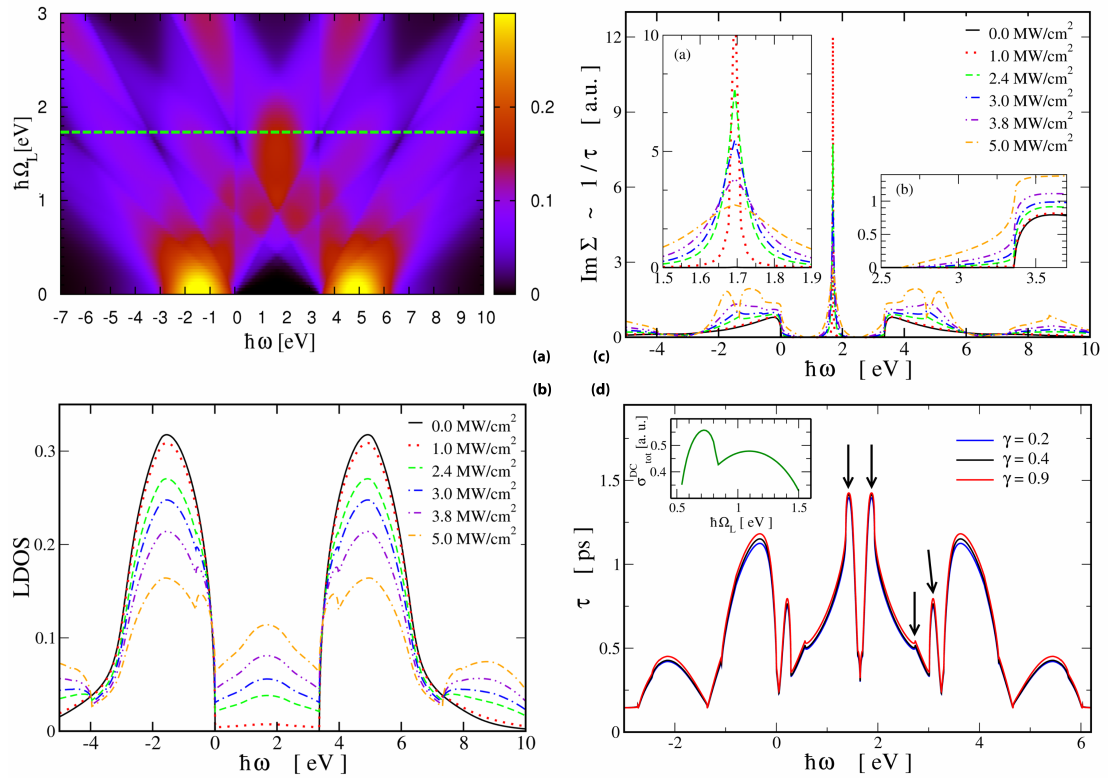
Figure 3. ( a ) LDOS of bulk ZnO for varying excitation laser frequency Ω L . The electronic gap in equilibrium is 3.38eV, the microscopic dipole moment equals | d | = 2.30826288 × 10 − 28 cm, the lattice constant is a = 0,325 nm . The excitation strength is 10.0 MW/cm 2 . A multitude of Floquet bands and sub-gaps emerge due to the AC Stark effect; ( b ) excitonic LDOS for the driving frequency if 1.75eV, with increasing intensity, 0 to 5.0 MW/cm 2 . Spectral weight is shifted into the Floquet bands which cross in the gap region. Mid-gap states emerge; ( c ) inverse excitonic lifetime Im Σ , 1/ τ , for parameters as in ( b ); ( inset a ) the peak centered at 1.69eV indicates small lifetimes and a fast decay of mid-gap states (red line); ( inset b ) the excitonic lifetime near the band edges is reduced but finite. With increasing pump intensity the near band-edge lifetime decreases but in comparison to the value in the band it is increased; ( d ) lifetimes of exciton-polaritons in ZnO nano-pillars. Parameters are: pump wavelength λ =